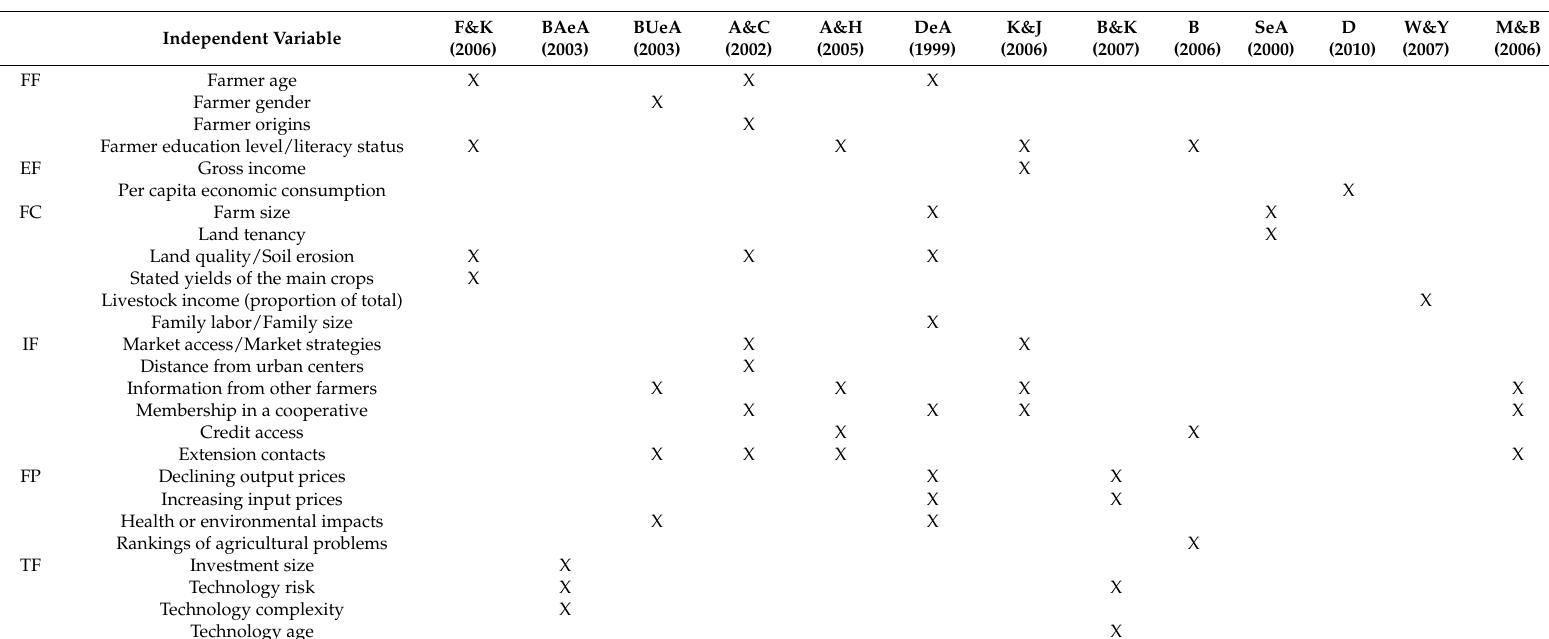
Table 1. Independent variables used in the literature. Boldfaced items in the list of variables are associated with boldfaced X’s in the body of the table. FF, farmer features; EF, economic factors; FC, farm characteristics; IF, institutional factors; FP, farmer perceptions; TF, technology